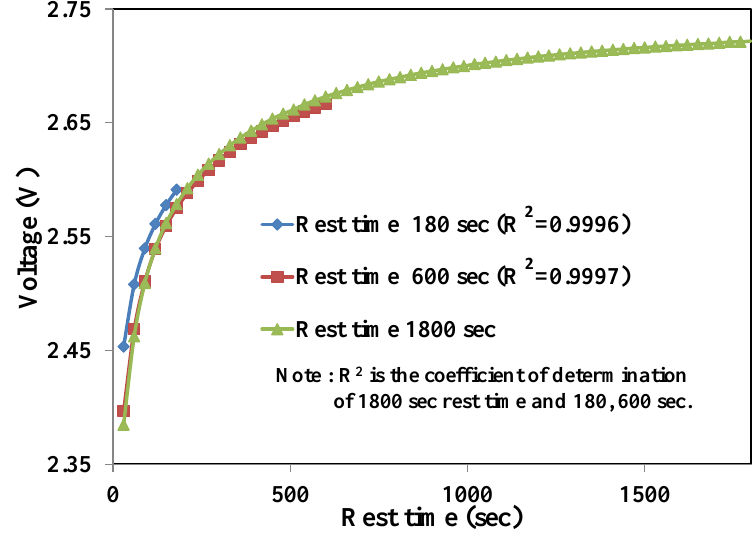
Figure 4. Fully discharged voltage recovers with rest time for three different